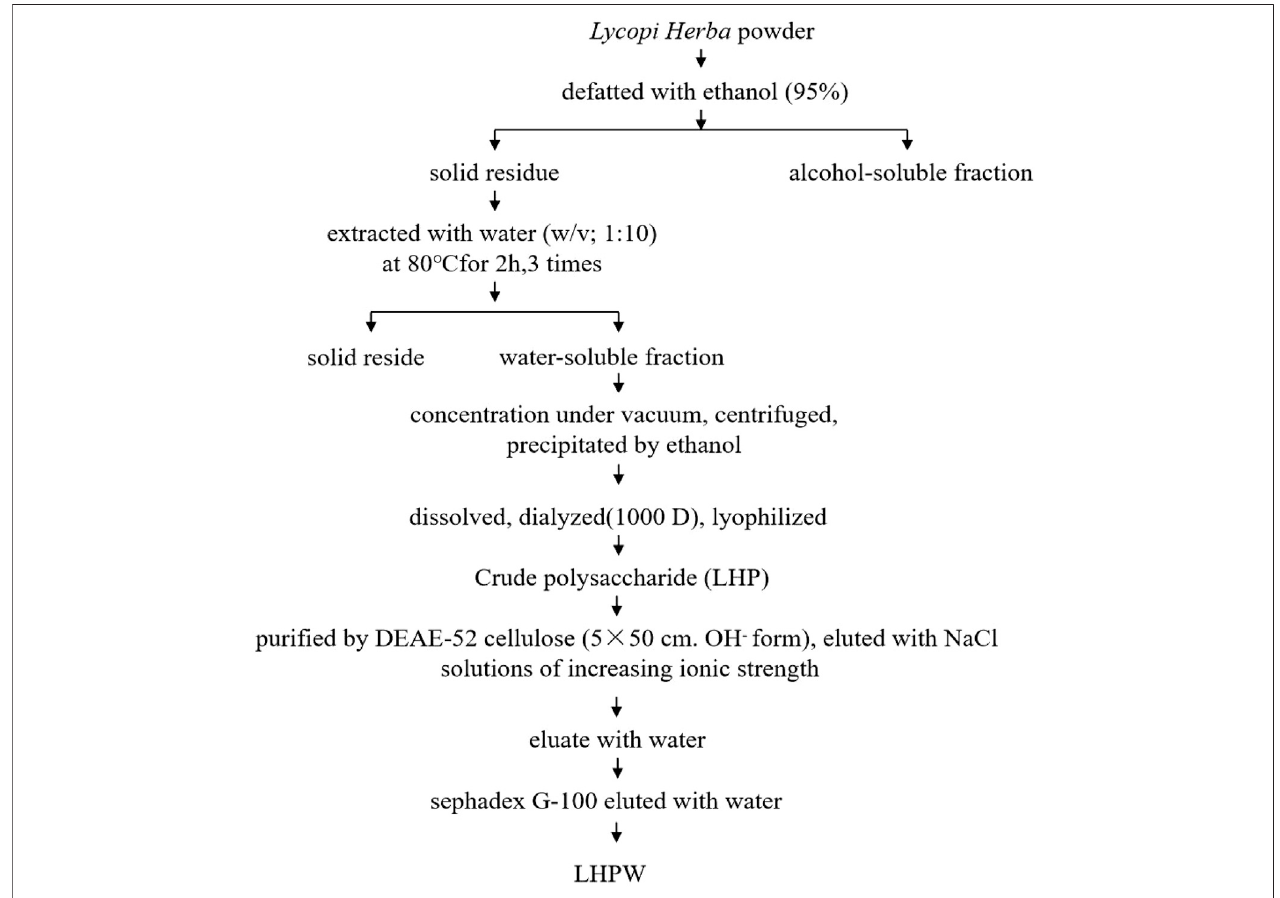
FIGURE 1 | Extraction and puri fi cation scheme of polysaccharide LHPW from Lycopi Herba.